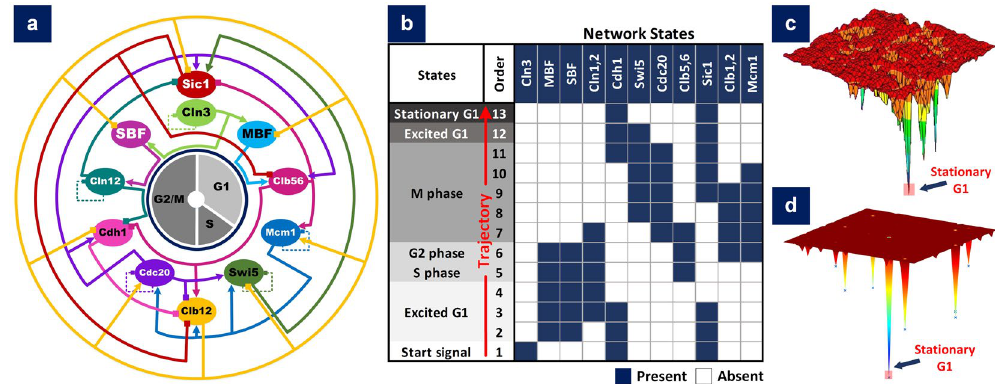
Figure 3. Decoding Yeast Cell Cycle Progression. ( a ) 11 node yeast cell cycle network adapted from Han et al ., ( b ) yeast cell cycle trajectory order (1 → 13) during cell fate adoption from start signal to stationary G1 phase, ( c ) attractor landscape constructed by Han et al ., ( d ) attractor landscape constructed using ATLANTIS toolbox.